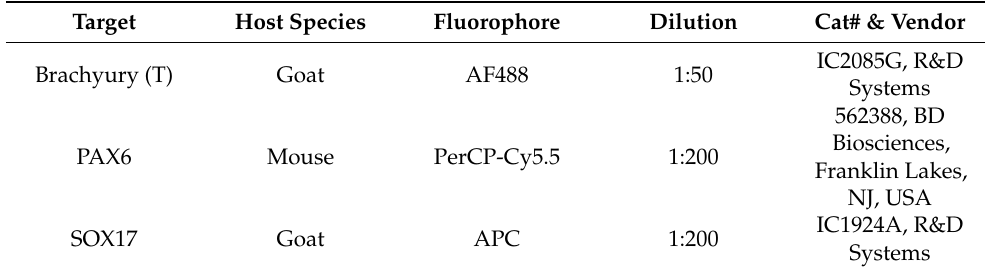
Table 4. Antibodies used in flow